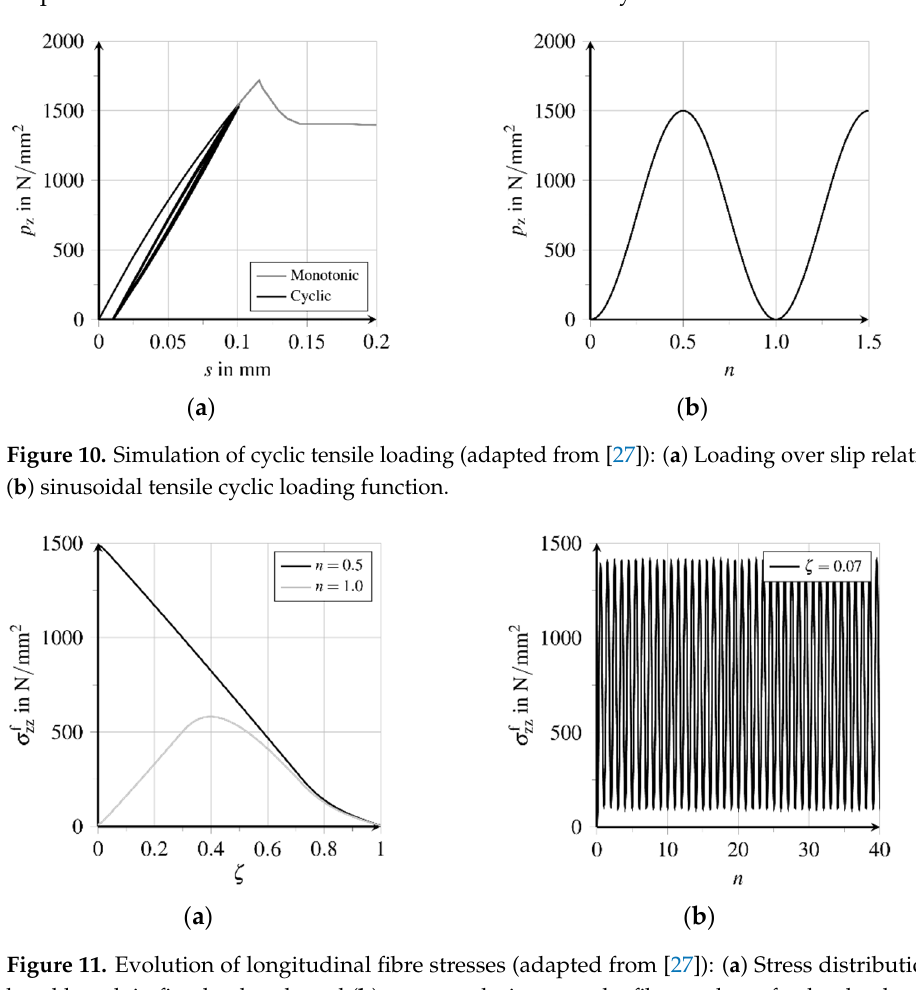
Figure 11. Evolution of longitudinal fibre stresses (adapted from [27]): ( a ) Stress distribution over bond length in first load cycle and ( b ) stress evolution near the fibre outlet at further load cycles.